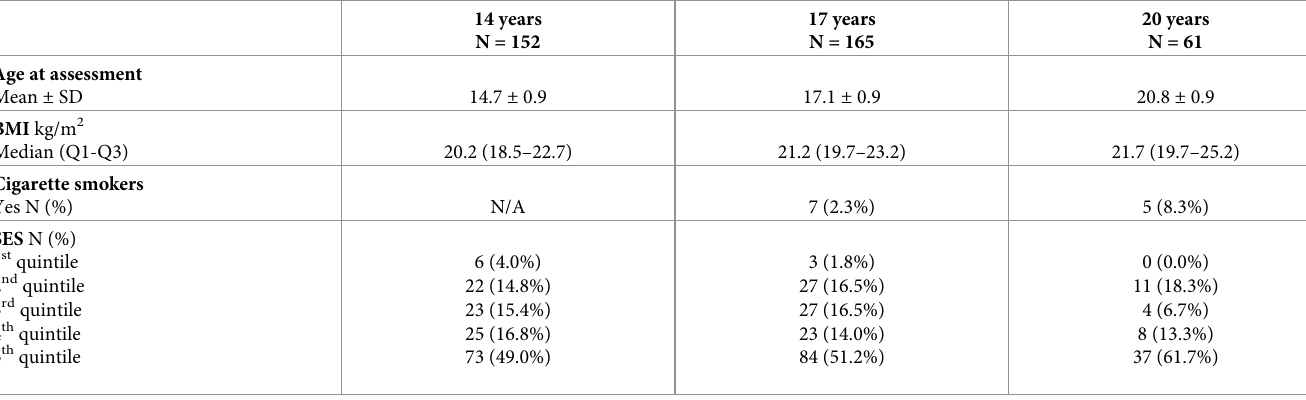
Table 3. Demographic characteristics per follow-up.